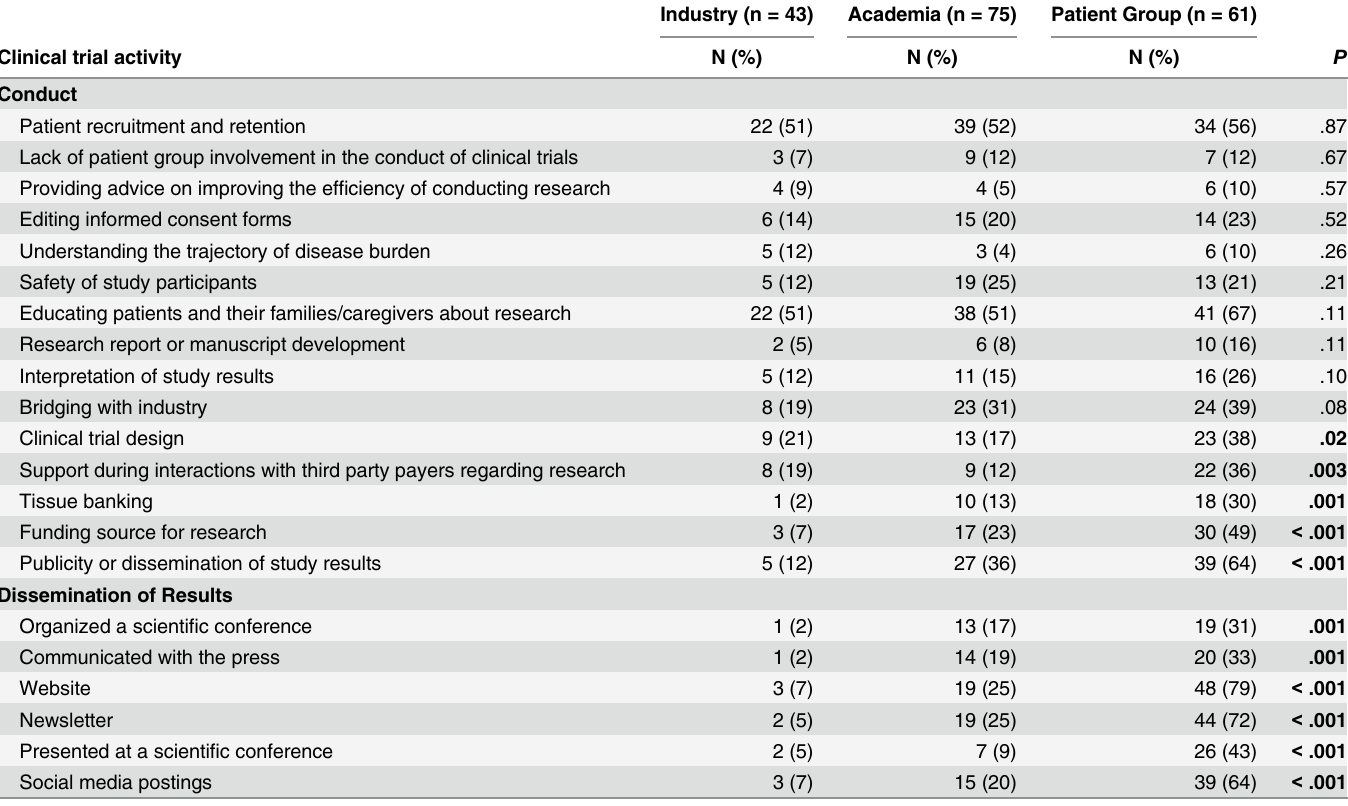
Table 3. Clinical Trial Services Provided to Industry and Academia by Patient Groups *